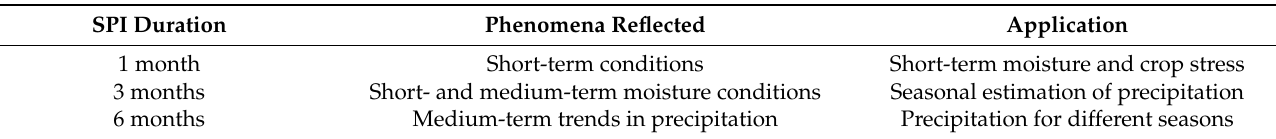
Table 1. Phenomena reflected by specific-duration standardized precipitation indices (SPIs) and their application [39].